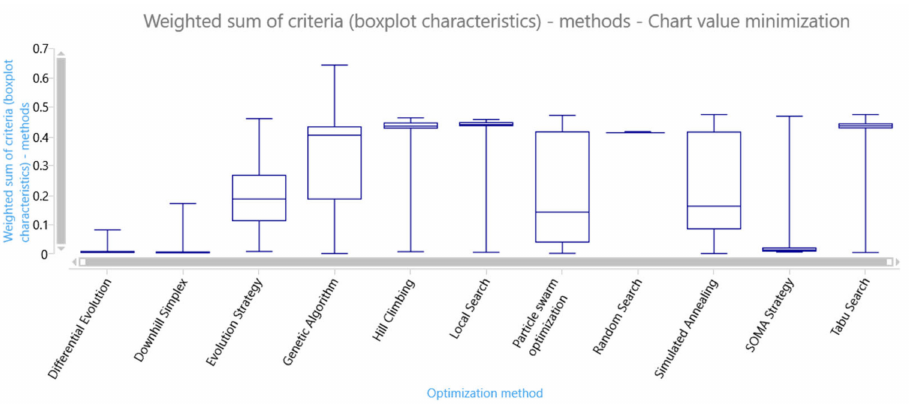
Figure 17. Box plot of solution candidate’s objective function values found by optimisation methods— the second termination criterion using the dimension of the search